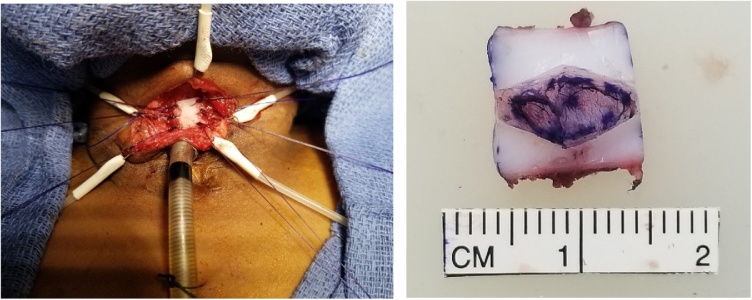
Images - A Double-Stage Laryngotracheoplasty with Anterior/Posterior Costal Cartilage Graft and Stent Placement (Anterior Graft shown).